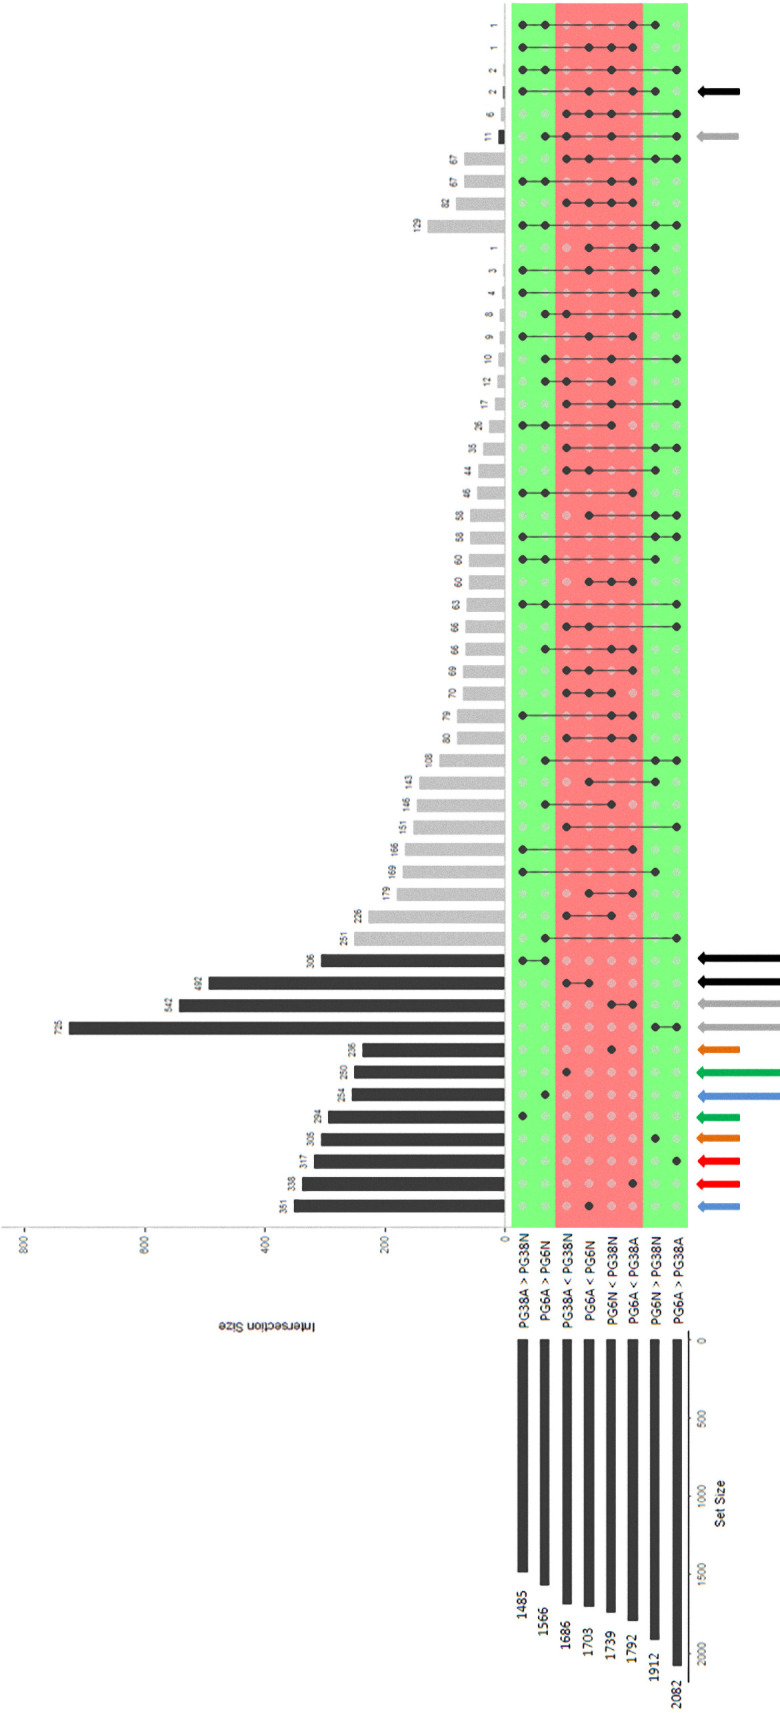
Plot of intersections between sets of genes differentially expressed.The intersected lists of differentially expressed genes and their sizes (number of DEGs) are presented in the horizontal bars on the left. The connected lines among the lists represent their intersections. The vertical bars and associated numbers correspond to specific overlap of DE gene sets. The legends of colored arrows are explained in the text. The significance of gene expression changes was inferred based on an adjusted p-value < 0.05. <: number of DEGs underexpressed in the first condition compared to the second. >: number of DEGs overexpressed in the first condition compared to the second. A: acidic pH and N: neutral pH.